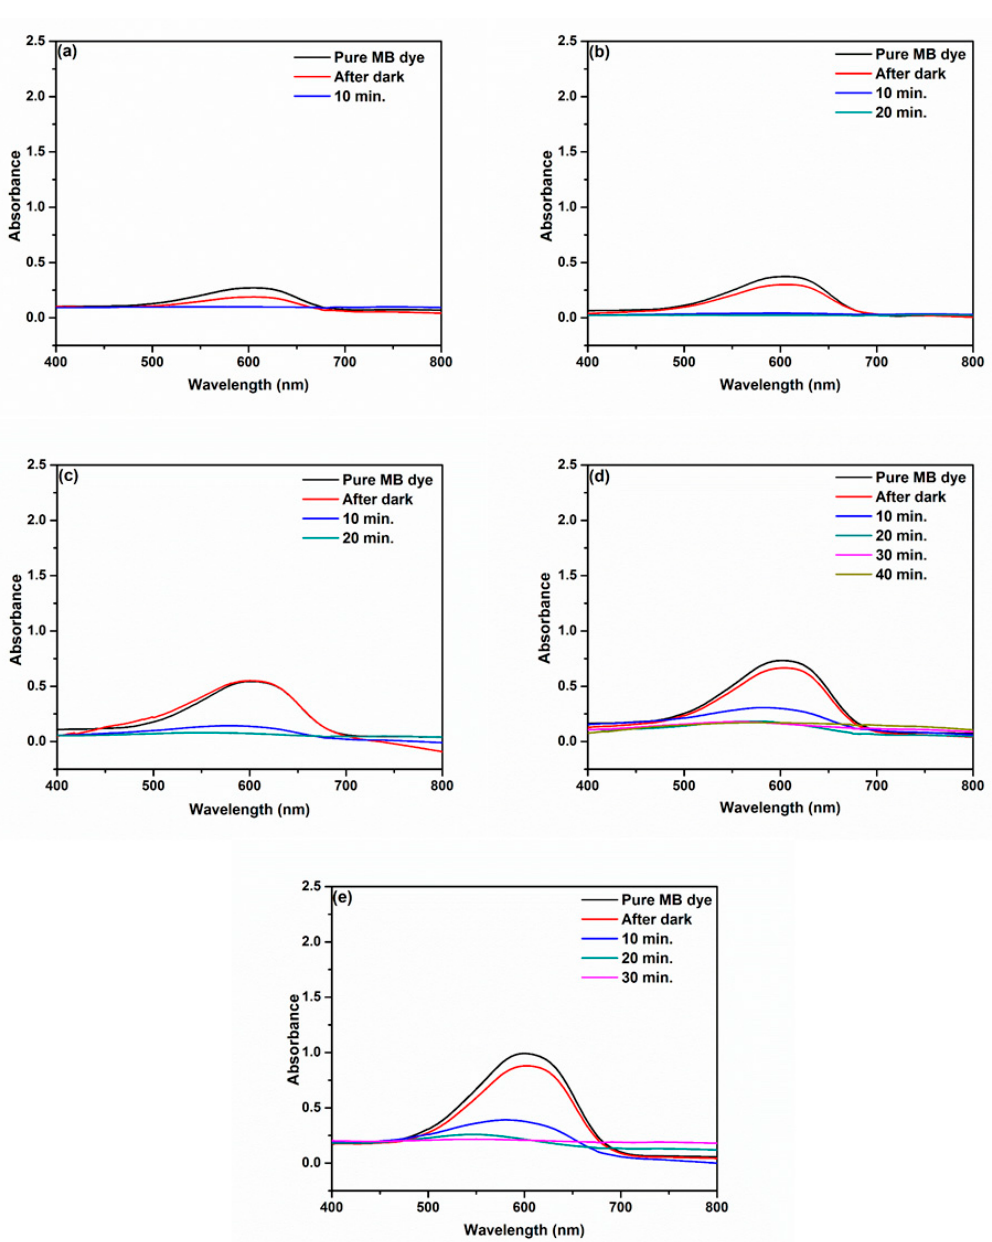
Figure 9. MB dye decolorization by 5% AgFeO 2 / rGO / TiO 2 photocatalyst for various concentrations: ( a ) 10, ( b ) 20, ( c ) 30, ( d ) 40, and ( e ) 50 ppm MB dye solution.